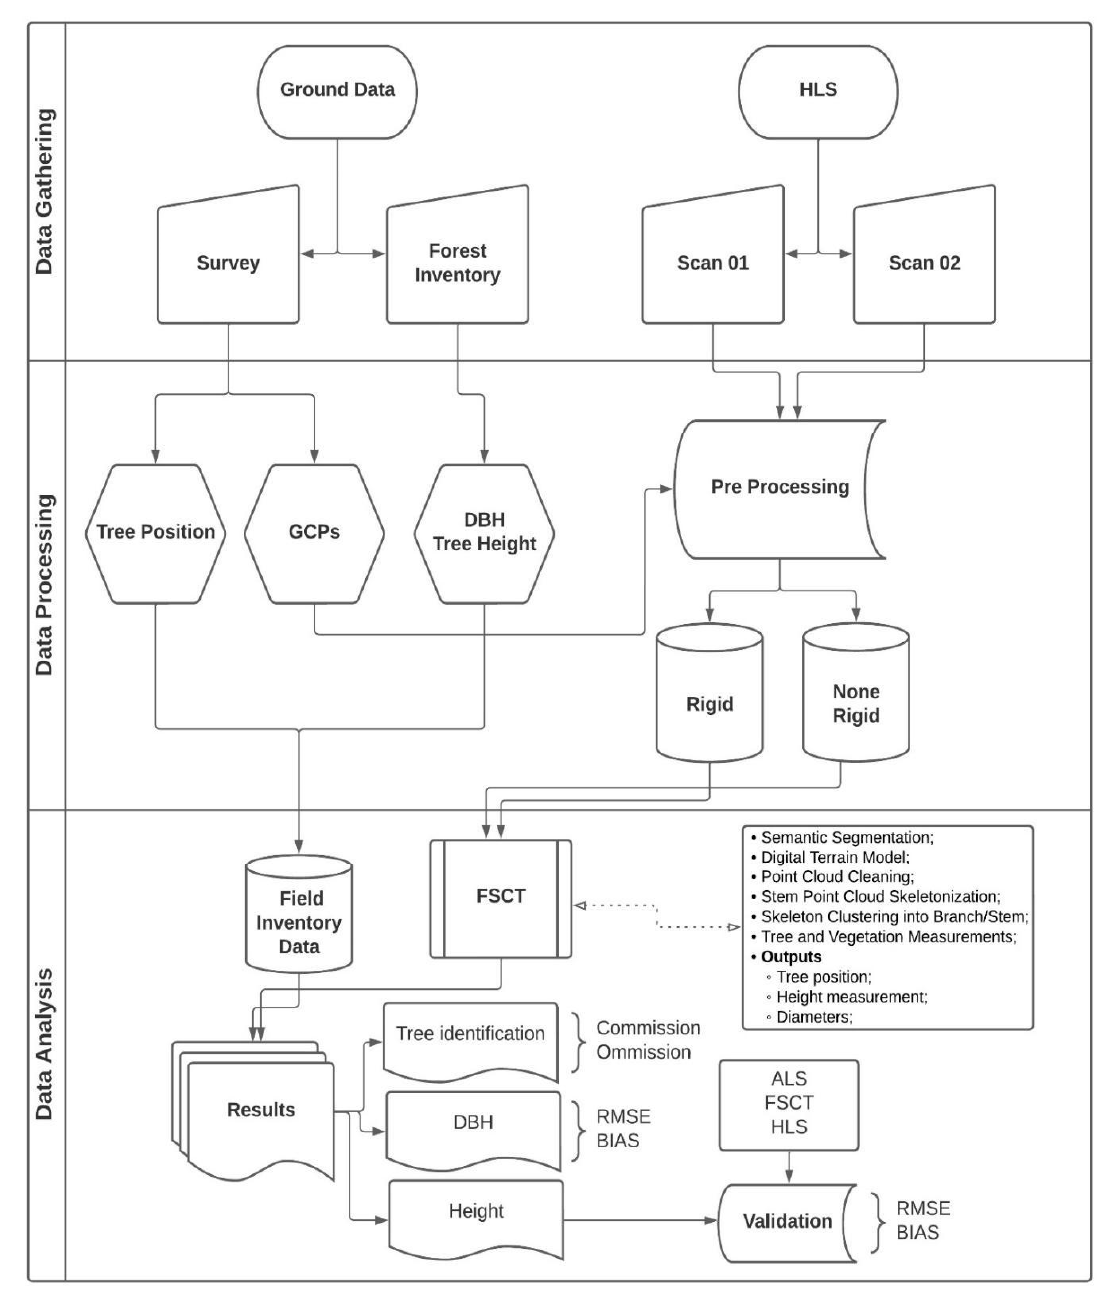
Figure 5. Summary of the workflow performed in this research using handheld laser scanning (HLS), the Forest Structural Complexity Tool (FSCT), airborne laser scanning (ALS) to estimate tree detection, diameter at breast height (DBH) and tree height using reference data for calibration.